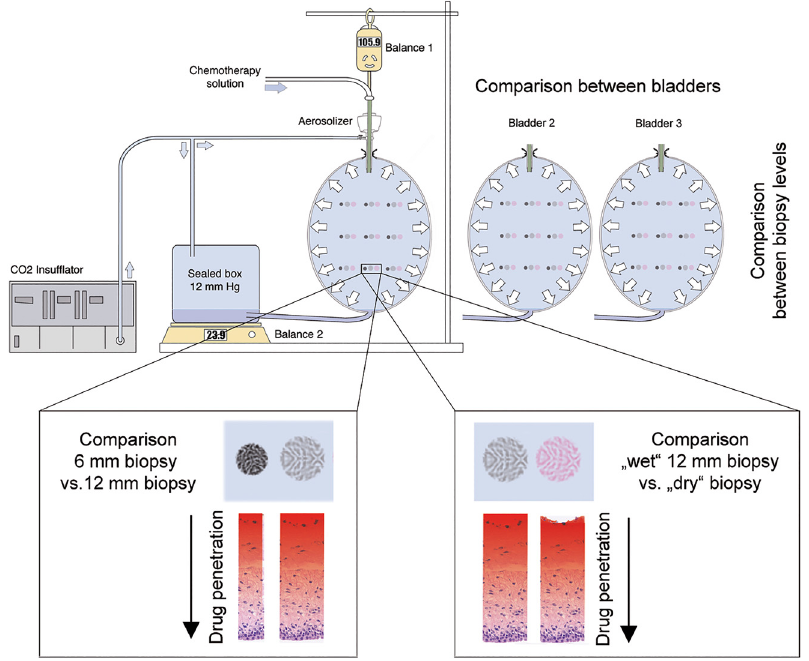
Figure 1: Study flow. Schematic representation of the eIBUB model and study design. Influence of biopsy geometry: 6 and 12 mm biopsies were taken at the top, middle, and bottom liquid layer on the surface: 12 mm punch